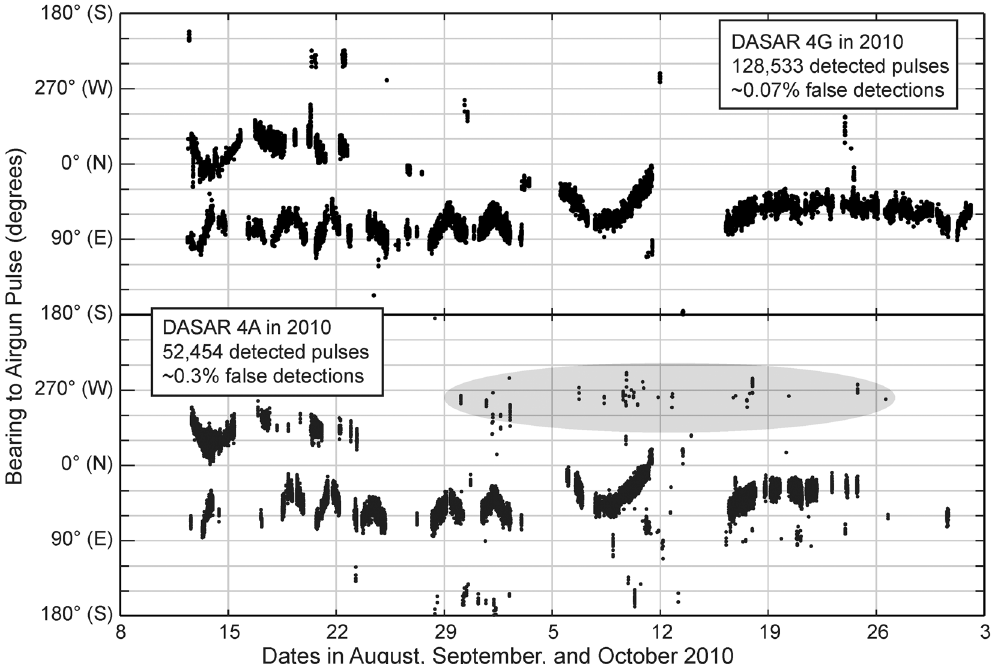
Fig 4. Bearings to airgun pulses as detected at DASARs 4A and 4G during the 2010 season. The originators of these airgun pulses were two distant operations (see section Airgun Activities during 2007 – 2010 above). The gray oval highlights examples of false detections (i.e., impulses of sound that are not airgun pulses). In deeper water (i.e., DASAR 4G) the number of detected pulses is higher and the percentage of false detections is lower. See text for more